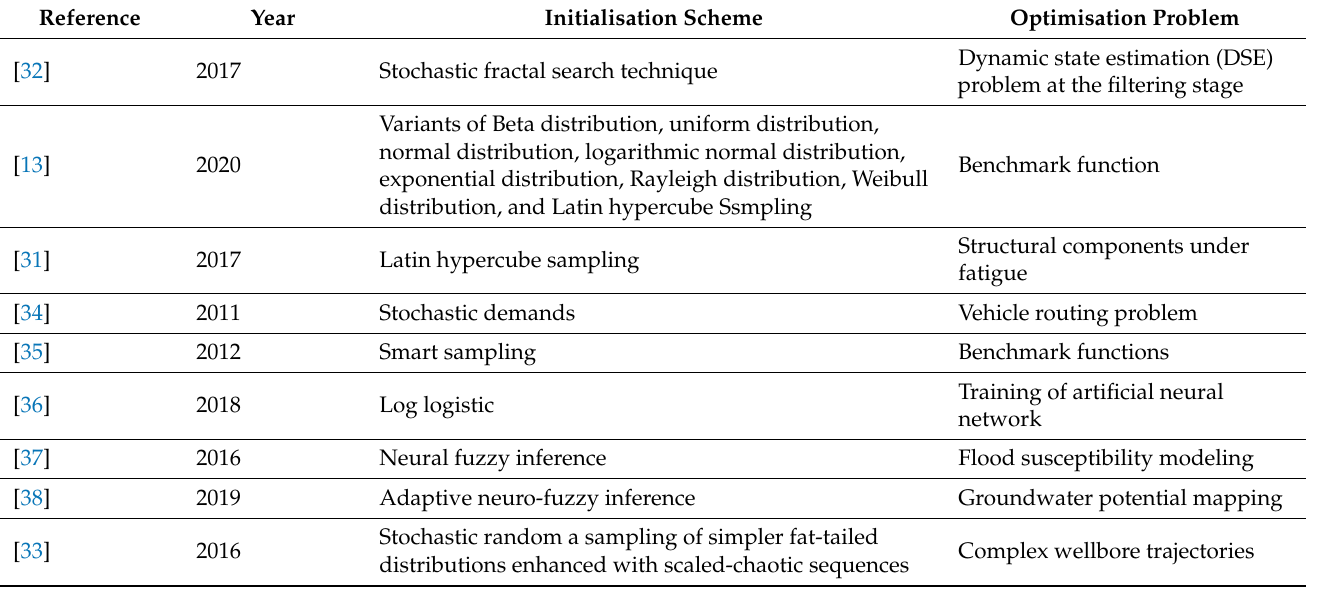
Table 3. Summary of PDF